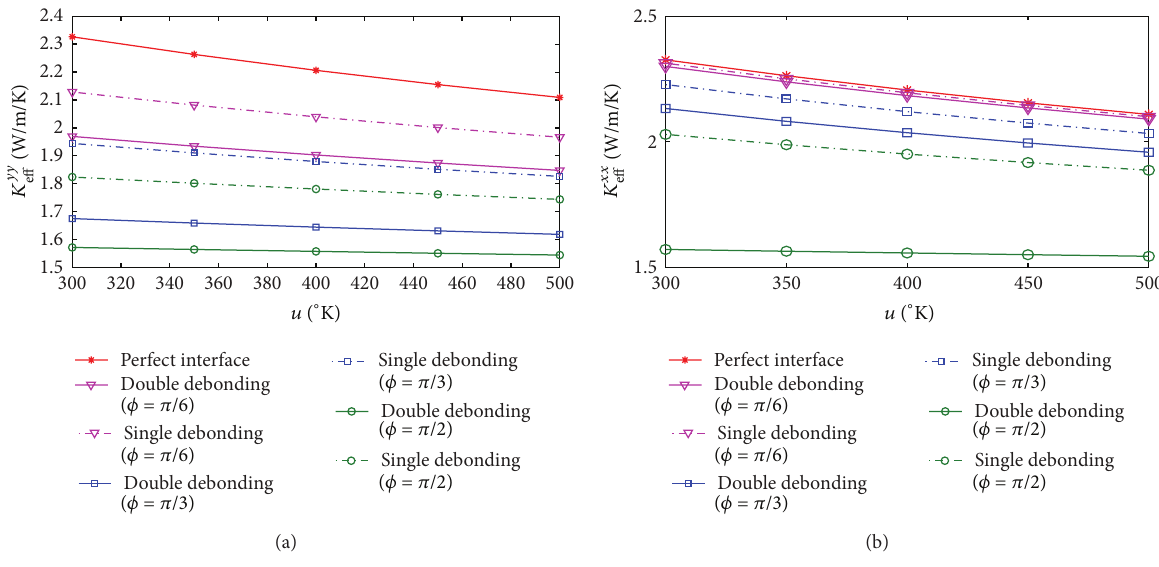
𝑦𝑦 ;(b)horizontaldirections eff